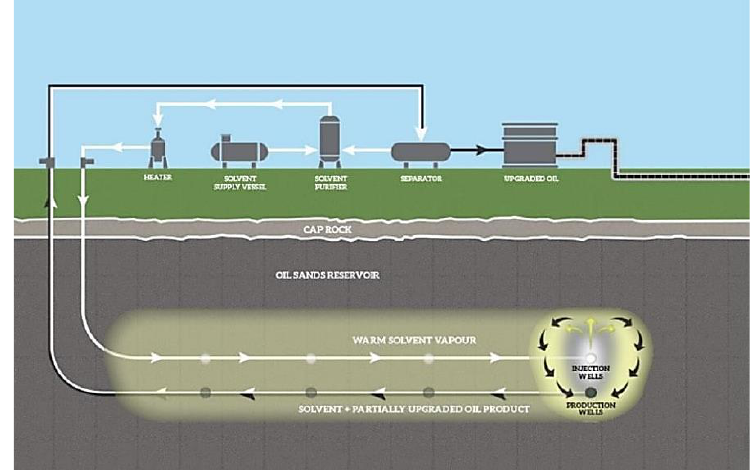
Figure 4. Schematic diagram of N-SOLV [33].